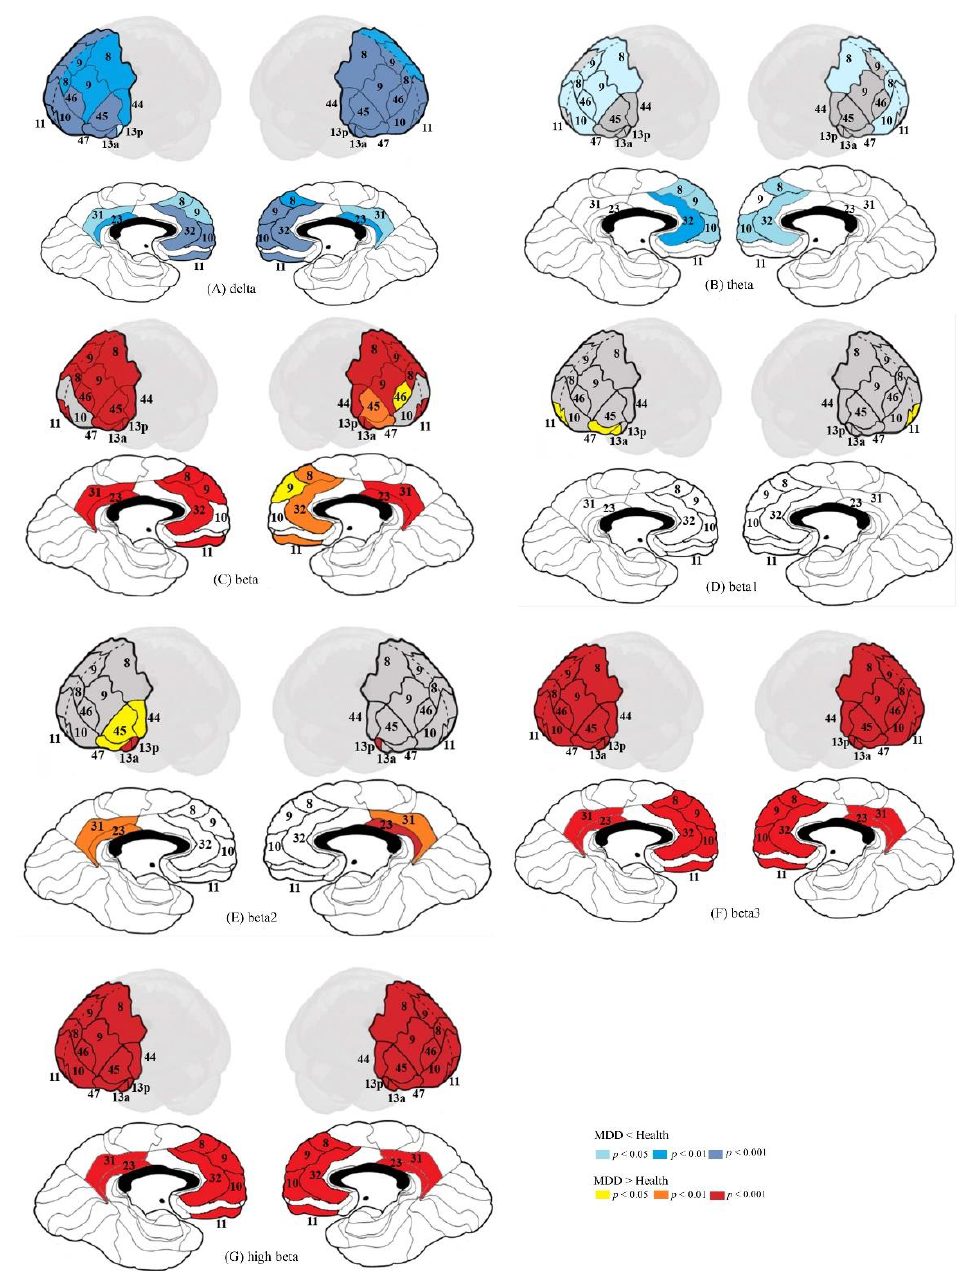
Figure 1. Deep brain activity of different frequency bands for MDD and HC groups: ( A ) delta; ( B ) theta; ( C ) beta; ( D ) beta1; ( E ) beta2; ( F ) beta3; ( G ) high beta. Table 2. Deep brain activity in dmPFC, vmPFC, dlPFC, vlPFC, OFC, and PCC for MDD and HC groups.